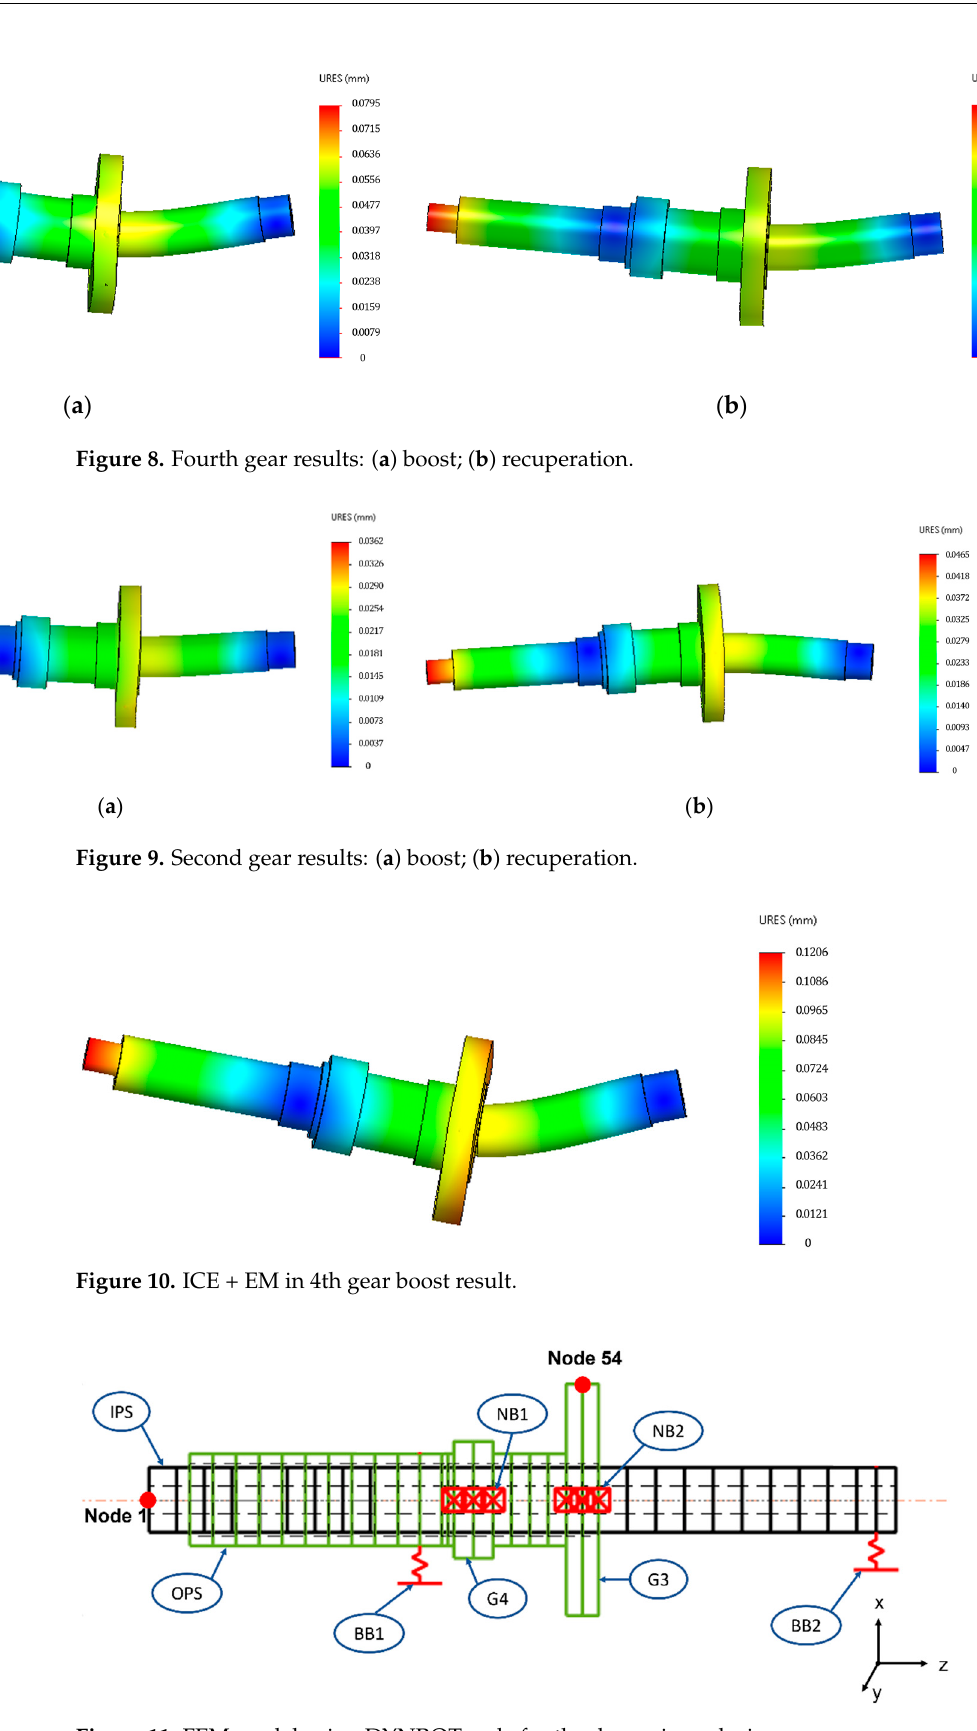
Figure 11. FEM model using DYNROT code for the dynamic analysis.